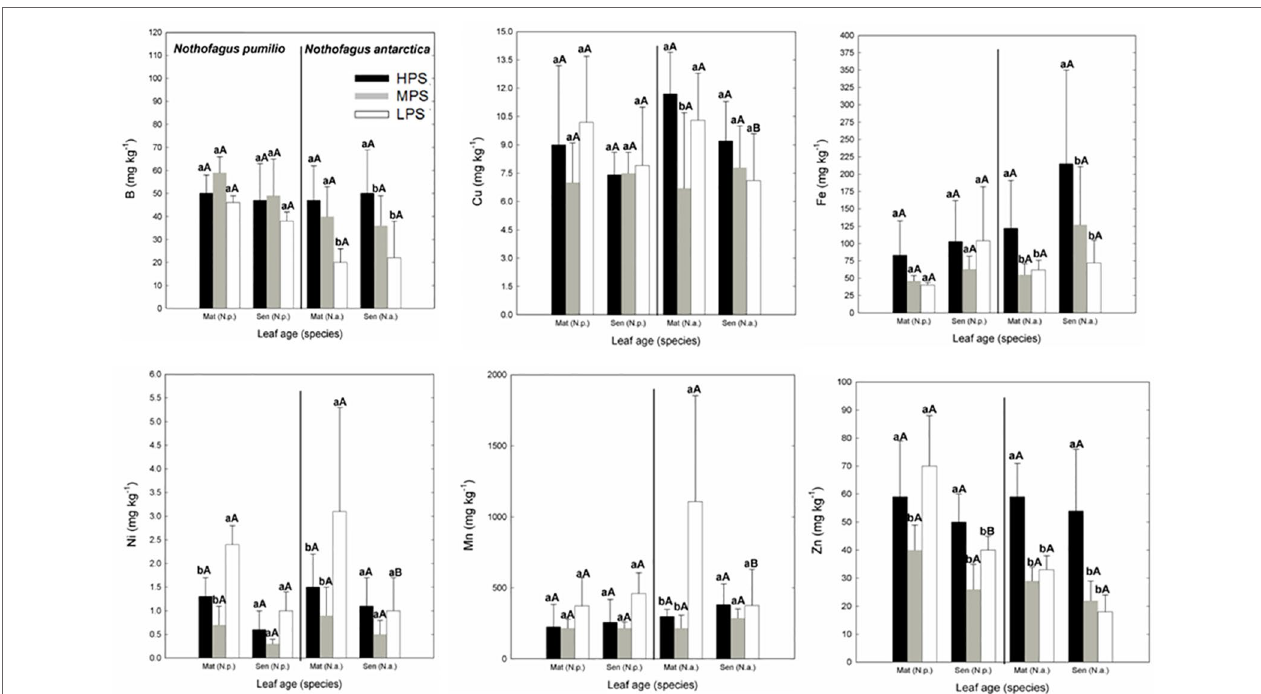
FiGURE 2 | Micronutrient (B, Cu, Fe, Mn, Ni, and Zn) concentrations of N. pumilio and N. antarctica leaves from three contrasting sites, collected at two developmental stages (mature and senescent). HPS, highly productivity site; MPS, medium productivity site; LPS, low productivity site. N.p., Nothofagus pumilio ; N.a., Nothofagus antarctica ; Mat, mature leaves; Sen, senescent leaves. Different lower case letters for the same species and age of leaves (mature or senescent) indicate significant differences (P < 0.05) between sites. Different capital letters for the same species and site indicate significant differences (P < 0.05) between age of leaves (mature or senescent). Bars represent the standard deviation of the